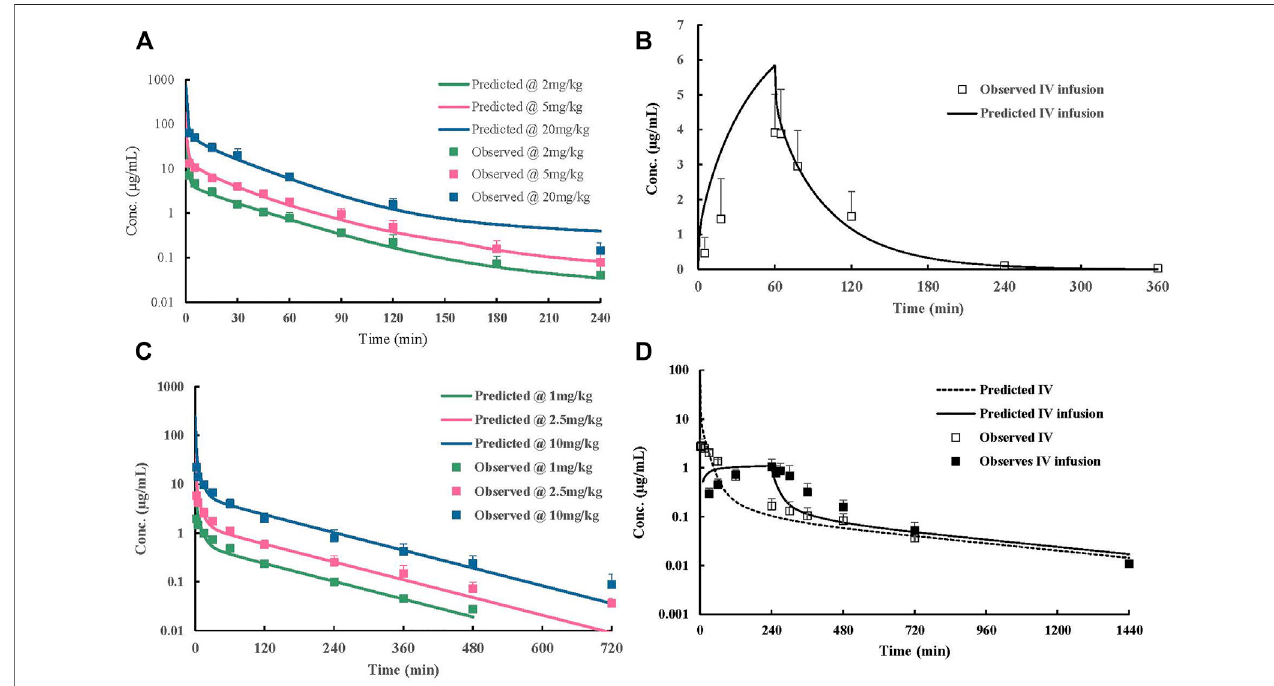
FIGURE 4 | Observed and predicted concentration – time pro fi les of ST-246 doses in animals. (A) Rats post-IV 2 – 20 mg/kg; (B) rats 5 mg/kg 1 h post-IV infusion; (C) dogs 1 – 10 mg/kg post-IV; (D) monkeys 3 mg/kg 4 h post-IV infusion. Scatter of points represent measured values; lines represent predicted the PK curve.